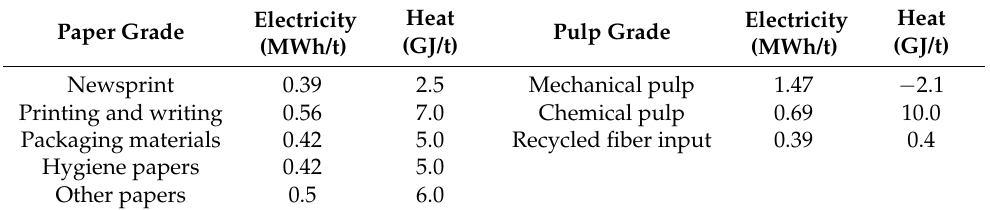
Table 2. Examples of the energy consumptions of different products. Data from Farla et al.